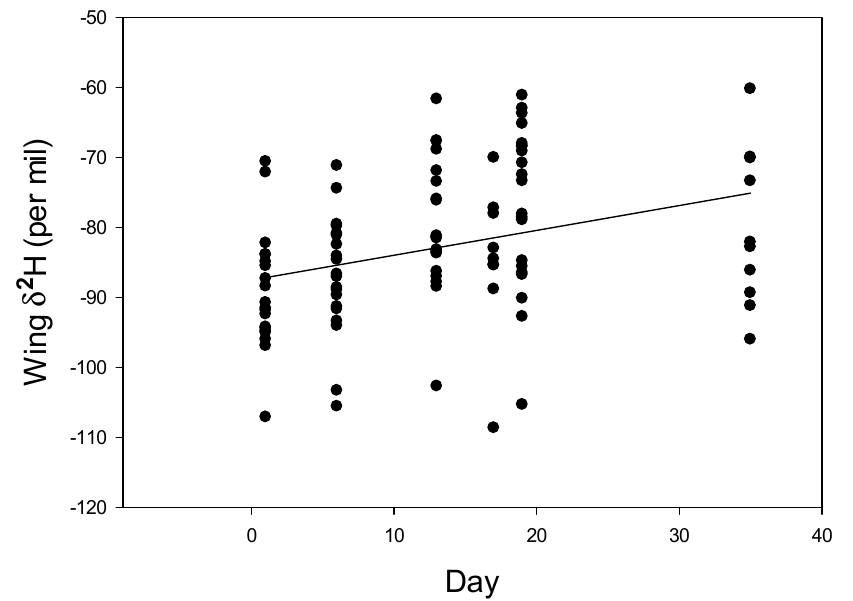
Figure 3. Relationship between wing δ 2 H and day of collection for Danaus gilippus . Intercepted in fall migration 2019 in northeast Mexico. Y = 0.35X − 87.5. r 2 = 0.11. Day 0 is 14 October.